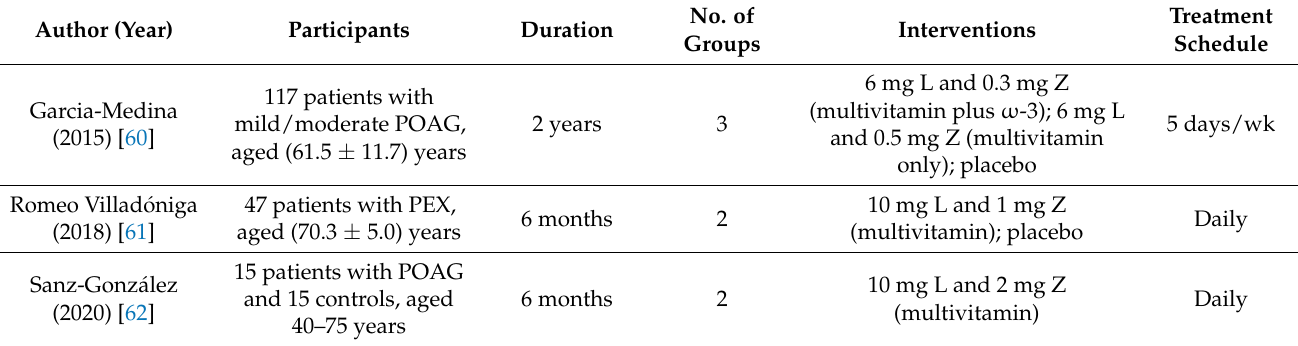
Table 3. Characteristics of the eligible randomized clinical